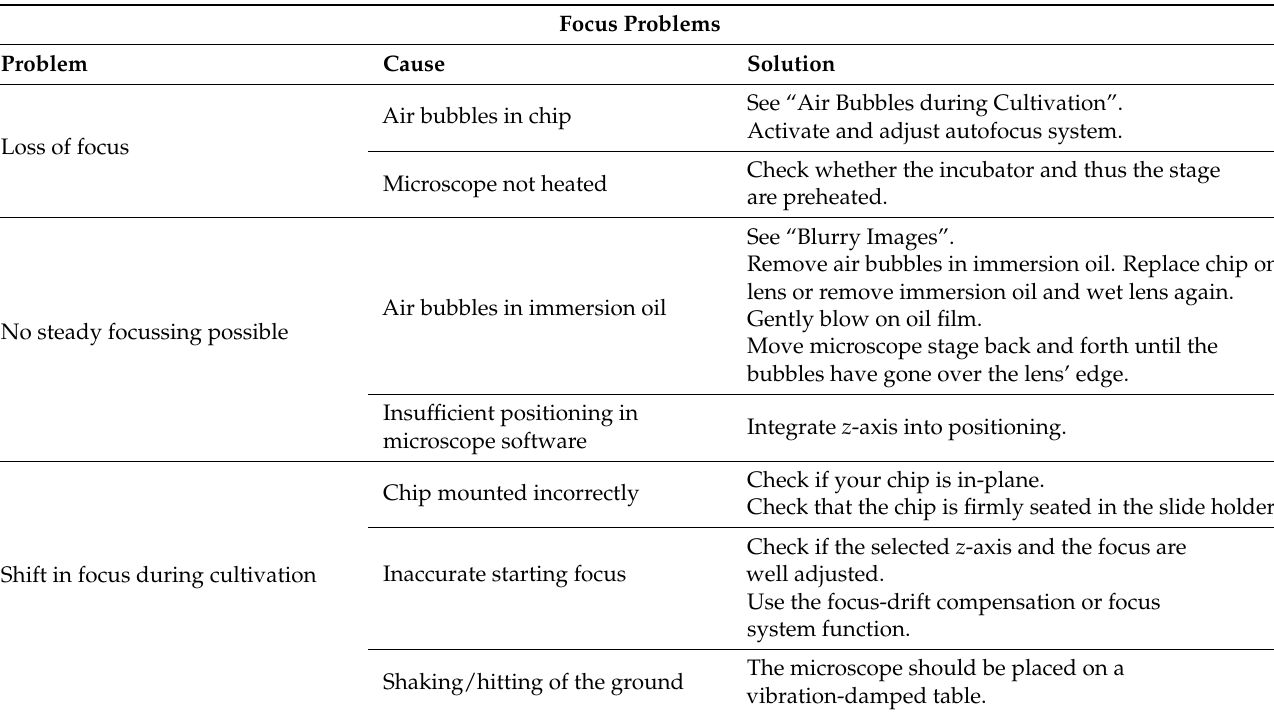
Table 11. Listed are the most frequently occurring challenges concerning focus problems with their respective cause and a suggested solution.